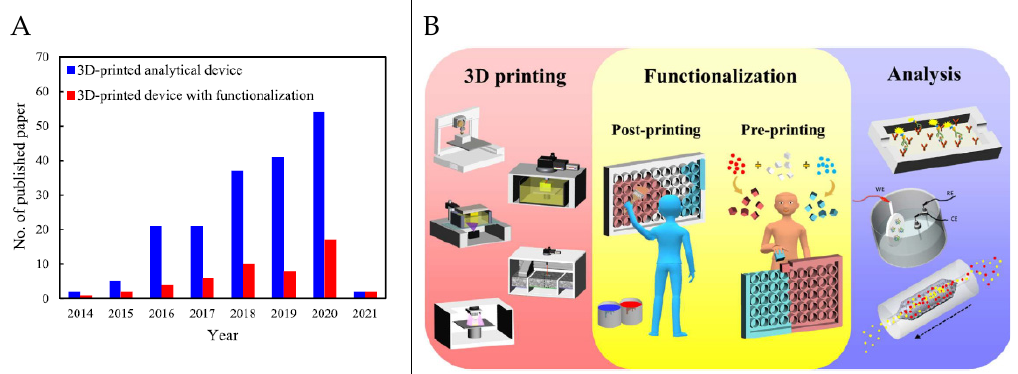
Figure 3. ( A ) Research interest in 3D-printed analytical devices and 3D-printed devices with functionalization. ( B ) Advances in functionalization of 3DP components for sensors and analysis. Reproduced with the permission of Reference [11]. Copyright 2017 Elsevier.